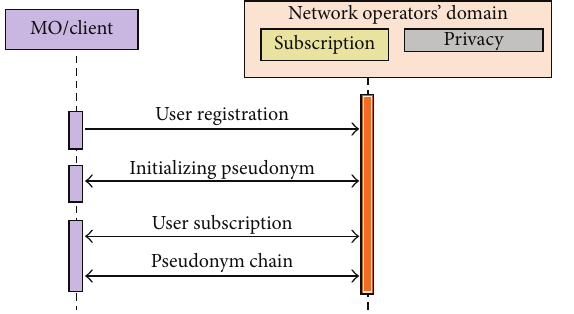
Figure 4: Registration, subscription, and the process of pseudo- nymization of the MOs in the Mix-Zones.